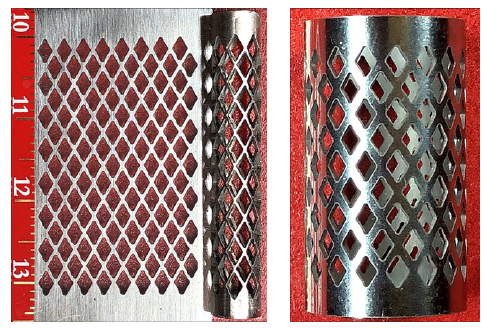
Figure 8: Diamond holes and metal mesh cages.